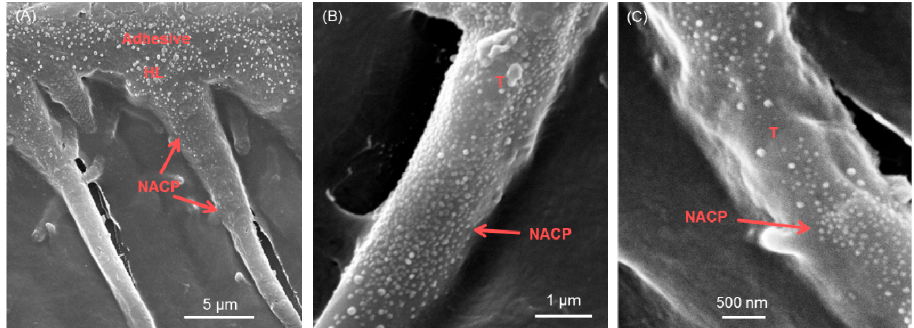
Figure 3. NACP in dentinal tubules. ( A ) Representative scanning electron microscopy (SEM) micrograph showing numerous NACP within the resin tags. ( B , C ) SEM micrographs of NACP particles within the resin tags at higher magnifications. Adapted from [78] with permission.